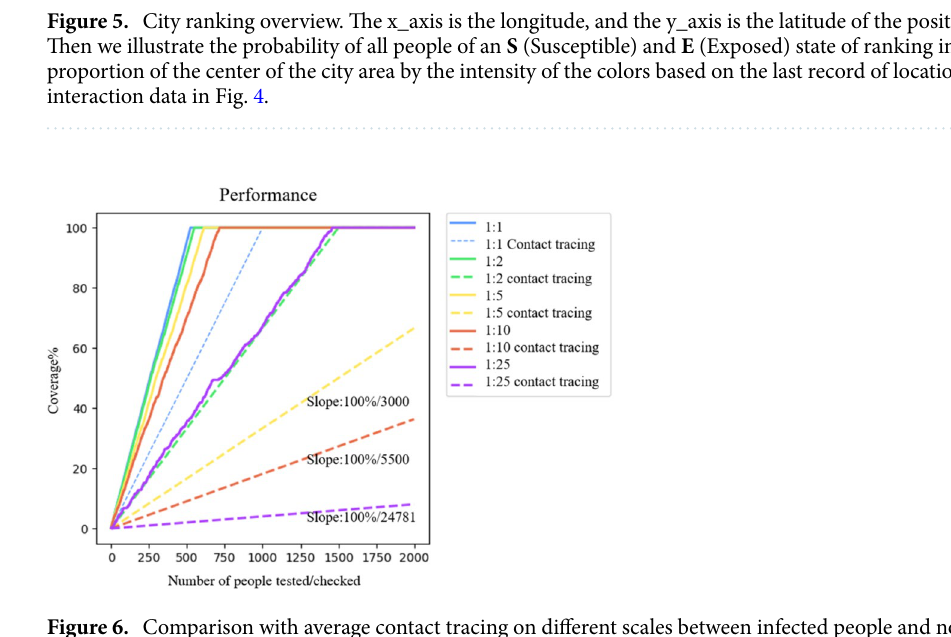
Figure 6. Comparison with average contact tracing on different scales between infected people and non- infected people. The base unit of the ratio is 500. The ratio shows the comparisons between infected people and non-infected people. The dashed line refers to the performance of ordinary contact tracing, and the solid line of the same color means the result obtained by the proposed method. If the testing follows the order of probability generated by our approach for a bigger group of people than the purple lines demonstrate, 1500 24781 ≈ 6% of people need to be tested in comparison with contact tracing, which means reducing up to 94% of screening resources